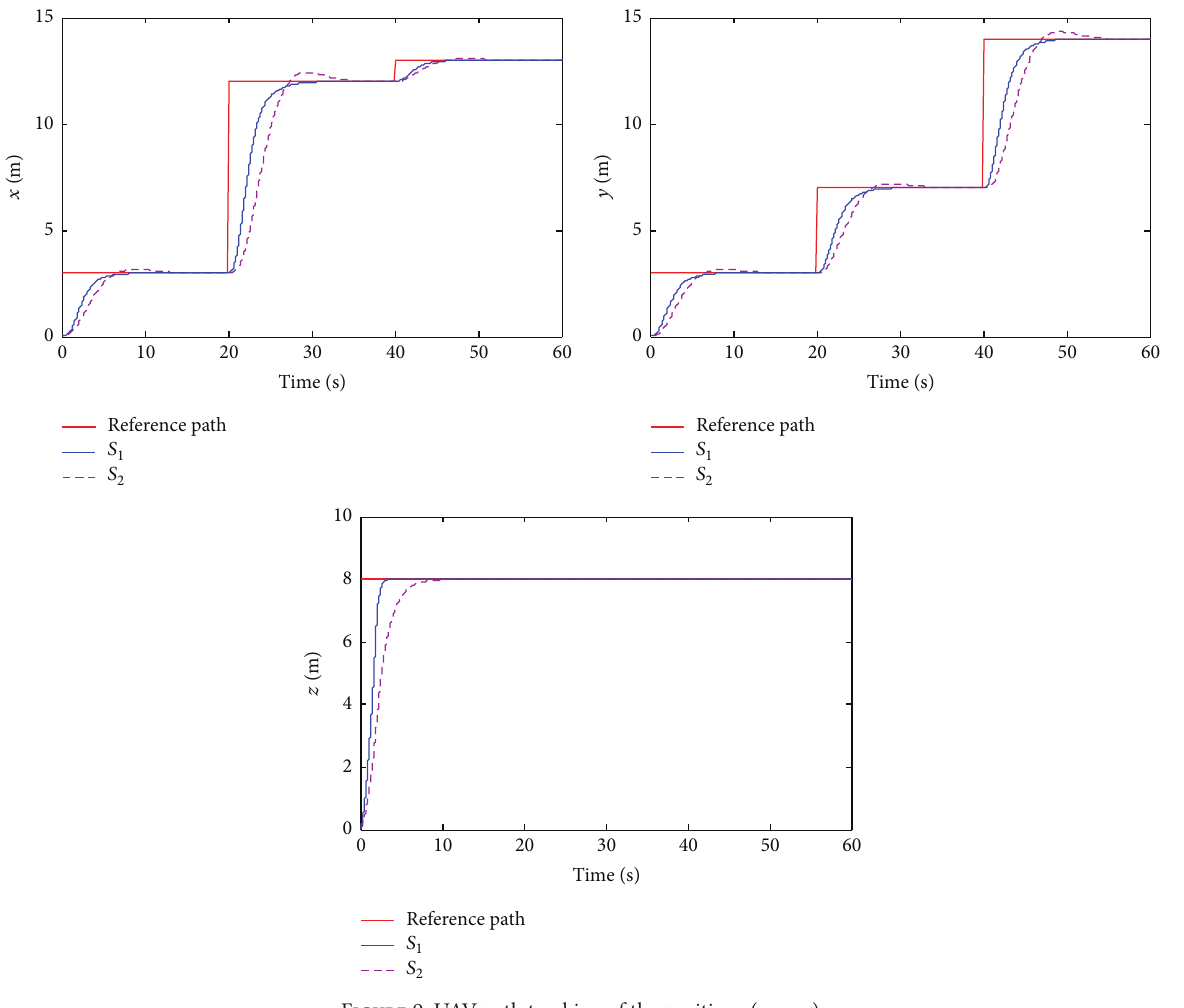
Figure 9: UAV path tracking of the positions (𝑥,𝑦, 𝑧)